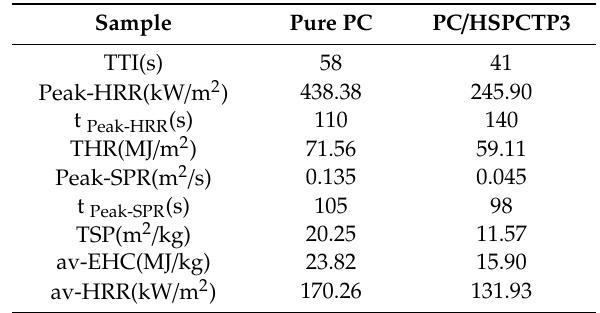
Table 3. Cone calorimeter data for pure PC and PC / HSPCTP3 composites.